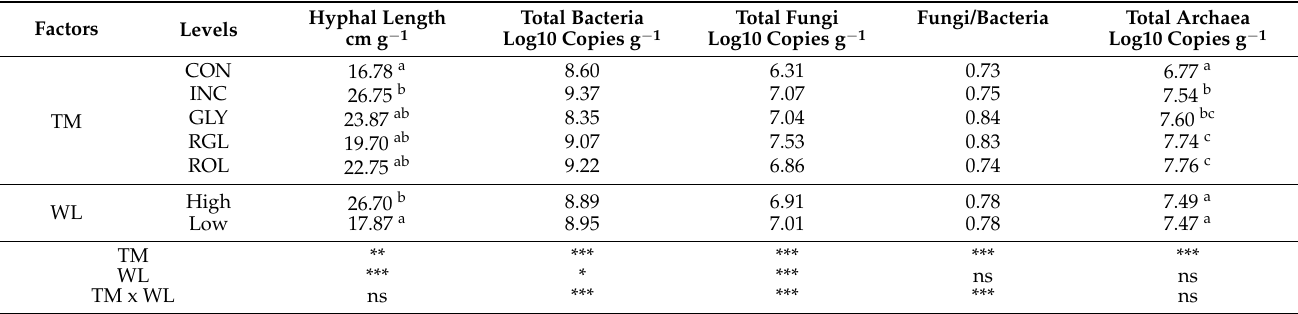
Table 1. Soil microbial variables as affected by termination method (TM) and water level (WL) at maize